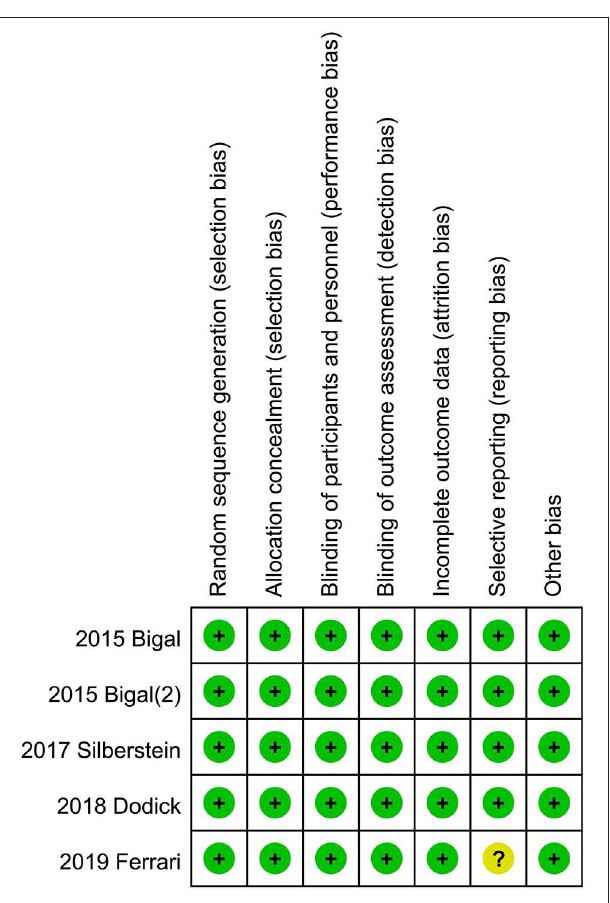
results of phase II and phase III trials (26). Bigal’s two studies were in phase IIB, but the other three studies were in phase